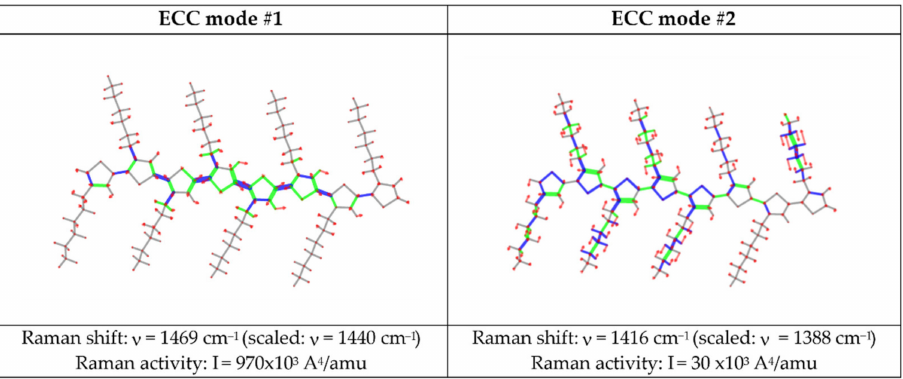
Figure 2. Computed vibrational displacements associated with the two strongest Raman bands of a 3H8T molecule. Calculations have been carried out with density functional theory simulations at the B3LYP/6-31G(d,p) level; details are in reference [63]. Red arrows represent displacement vectors; CC bonds are represented as green and blue lines of different thicknesses according to their relative stretching